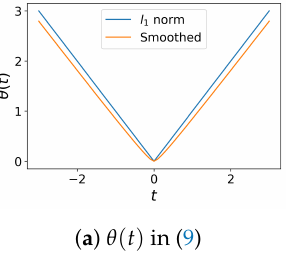
Figure 3. Nikolova and Steidl’s smooth approximation of l 1 norm: ( a ) l 1 norm denoted by a blue line is smoothly approximated by θ ( t ) denoted by an orange line; ( b ) the derivatives of l 1 norm and θ ( t ) ; ( c ) the inverse functions of l 1 norm and θ (cid:48) ( t ) , which is denoted by ξ ( z ) ; ( d ) the derivatives of the inverse functions.